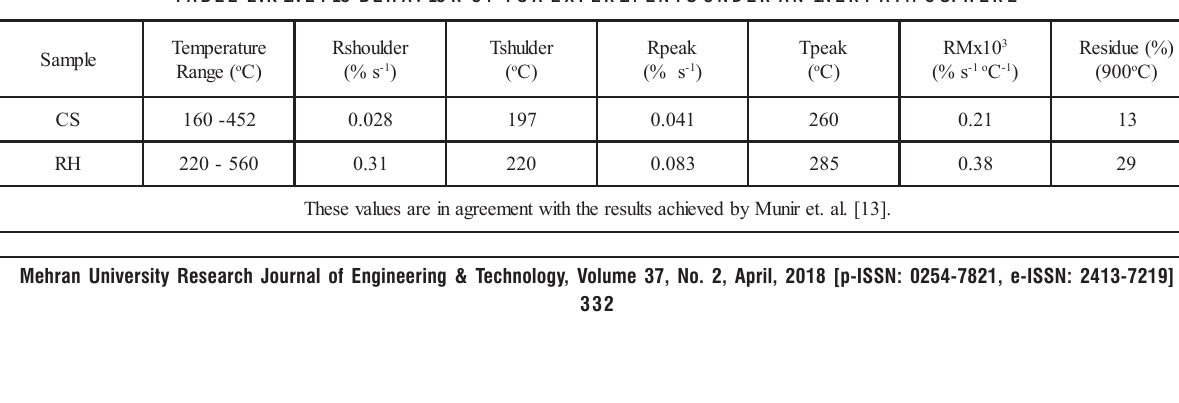
TABLE 2. KINETIC BEHAVIOR OF TGA EXPERIMENTS UNDER AN INERT